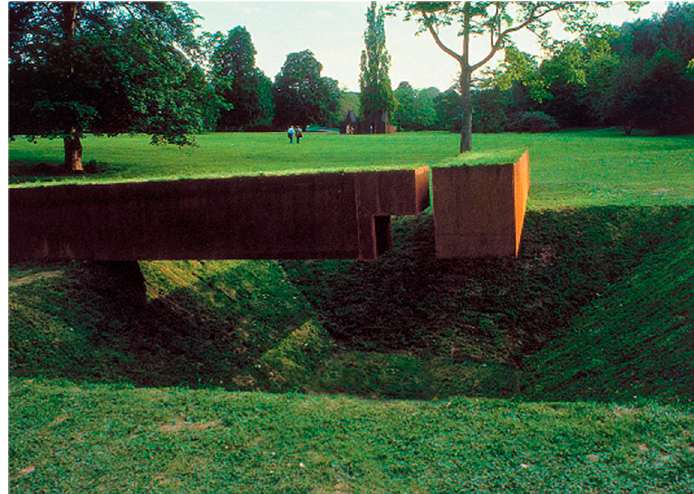
Figure 11. Ground ( Grund ), 1987. (Permanent) Skulptrenmuseum glaskasten, Marl, Germany. Iron, earth, grass, 15 m × 15 m. Depth: 3 m, height from the ground: 1.06 m. Photograph: Micha Ullman.